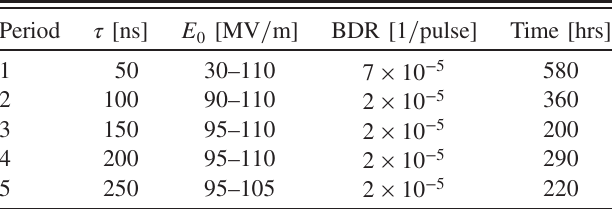
TABLE I. Main operational parameters during the conditioning of the TD26CC structure at